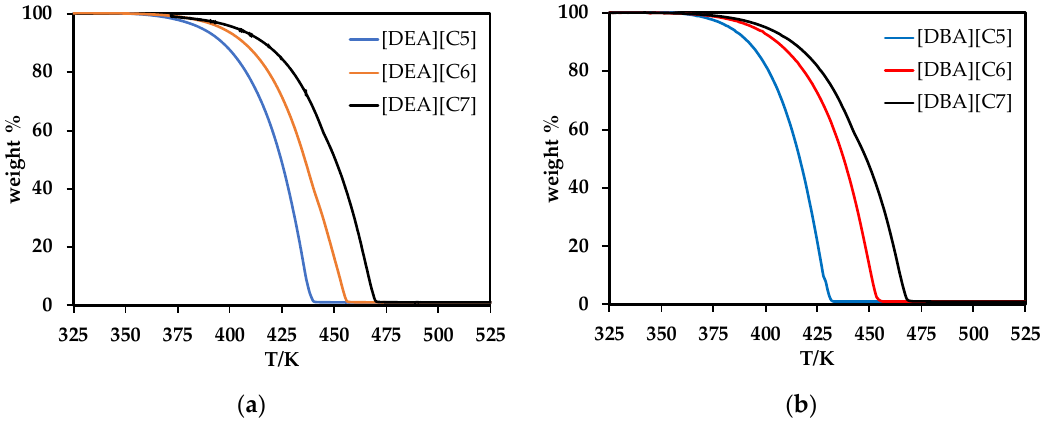
Figure 4. ( a ) Thermal decomposition curve of [DEA][C5], [DEA][C6] and [DEA][C7] at a heating rate of 10 °C·min −1 . ( b ) Thermal decomposition curve of [DBA][C5], [DBA][C6] and [DBA][C7] at a heating rate of 10 °C·min −1 .